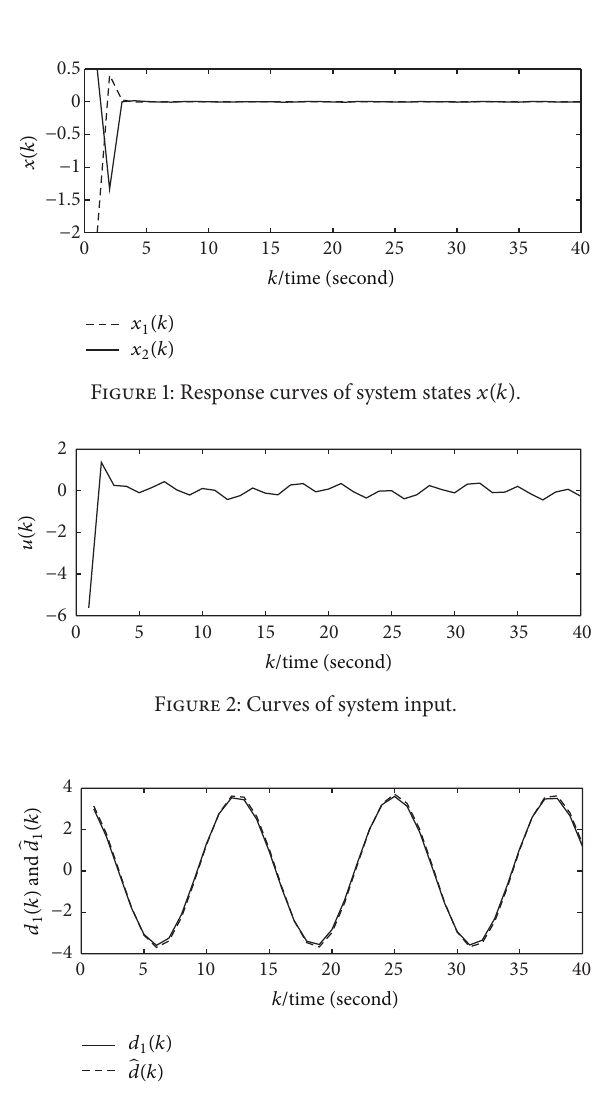
Figure 3: Curves of disturbances and disturbances